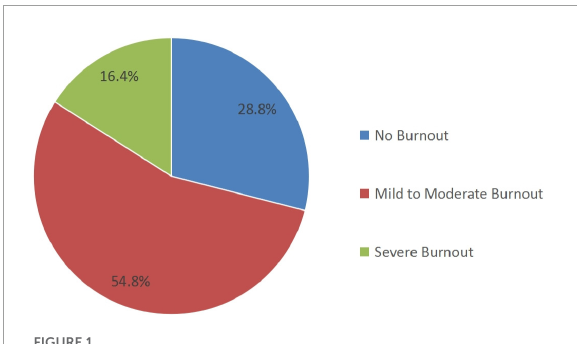
FIGURE1 Prevalence of burnout among stay-behind healthcare workers.